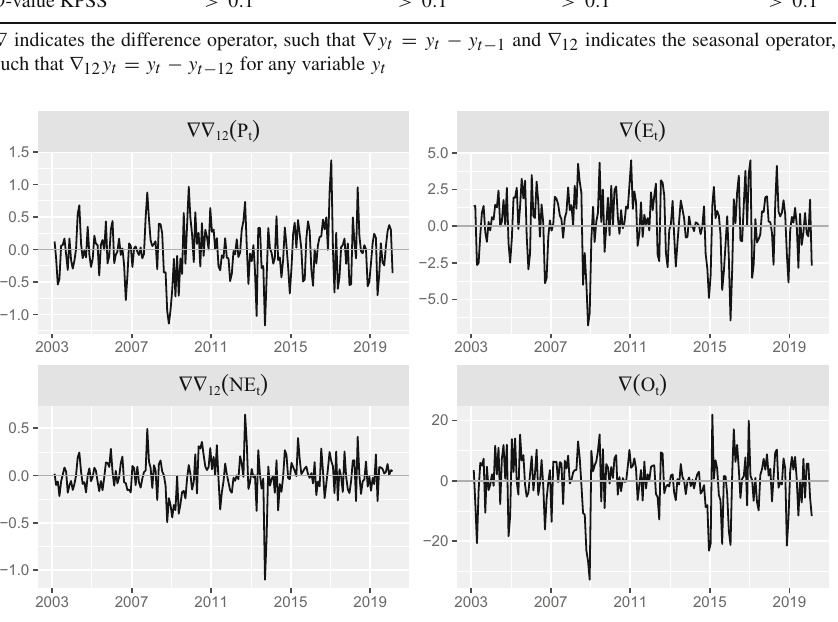
Fig. 2 Stationary transformations of the series in Fig. 1, Sample: